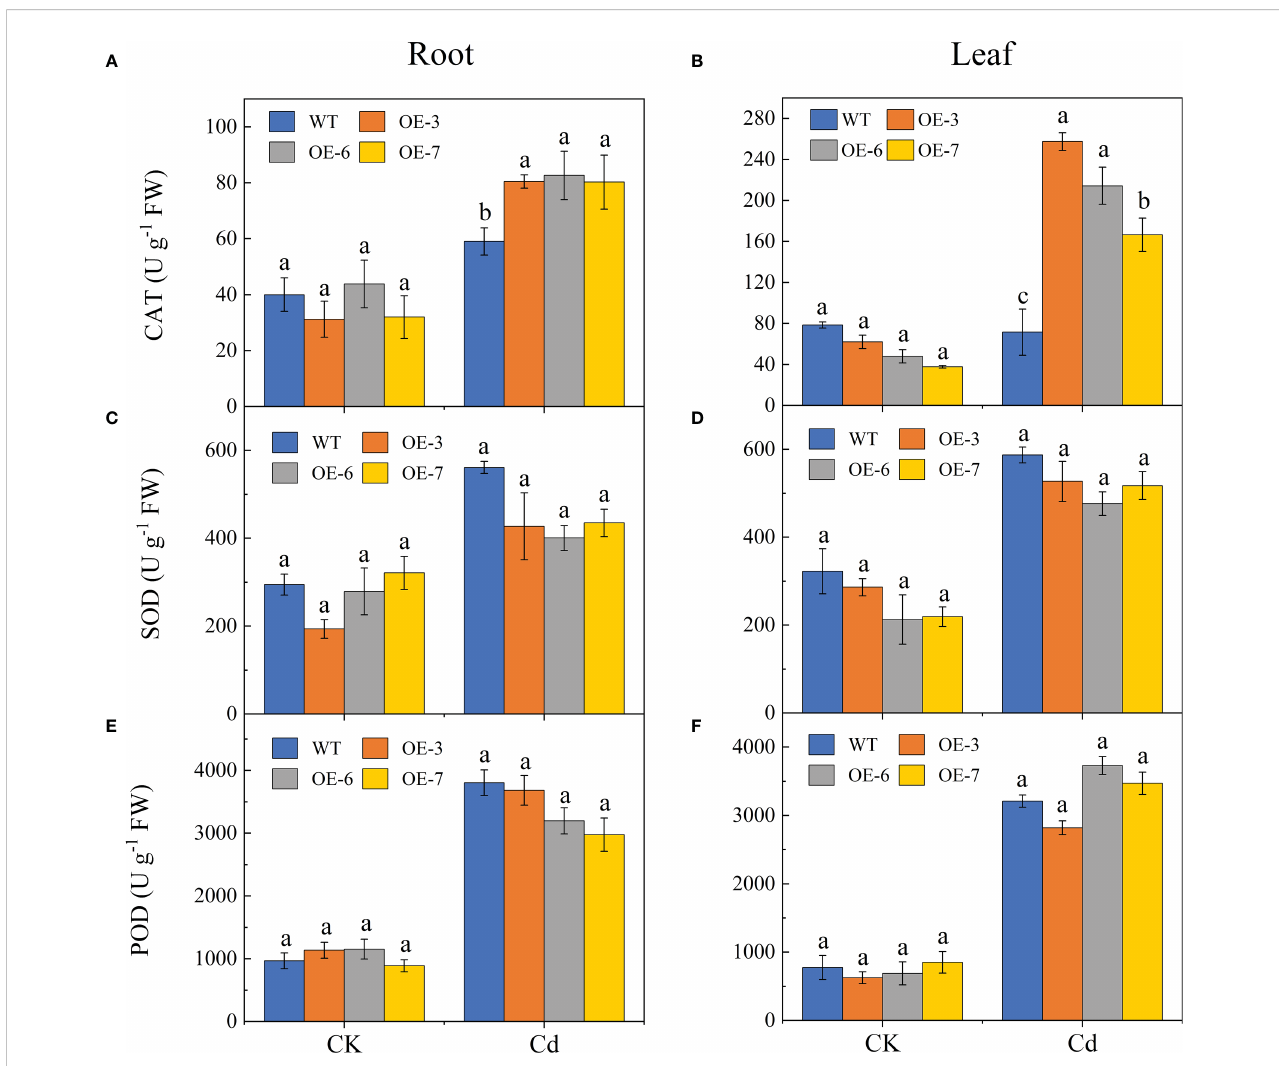
FIGURE 6 Effect of Cd stress on the antioxidant enzyme activities of the WT and SpCTP3 -overexpressing poplar roots and leaves. (A) Root CAT activities. (B) Leaf CAT activities. (C) Root SOD activities. (D) Leaf SOD activities. (E) Root POD activities. (F) Leaf POD activities. Data are presented as the mean ± SD of three independent replicates. Different letters above bars indicate signi fi cant differences among treatments ( p <